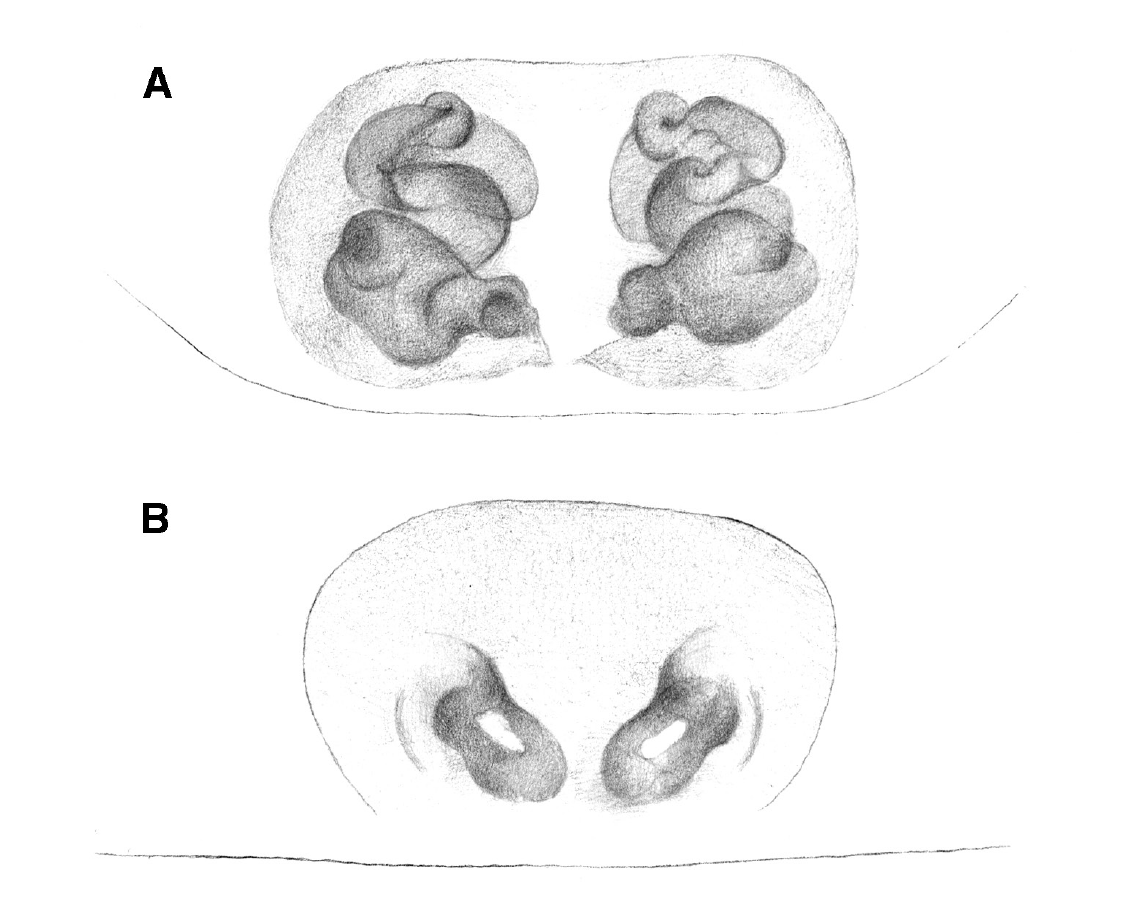
Fig. 3. — A . Mecaphesa inclusa (Banks, 1902), spermathecae. — B . M. reddelli sp. nov.,